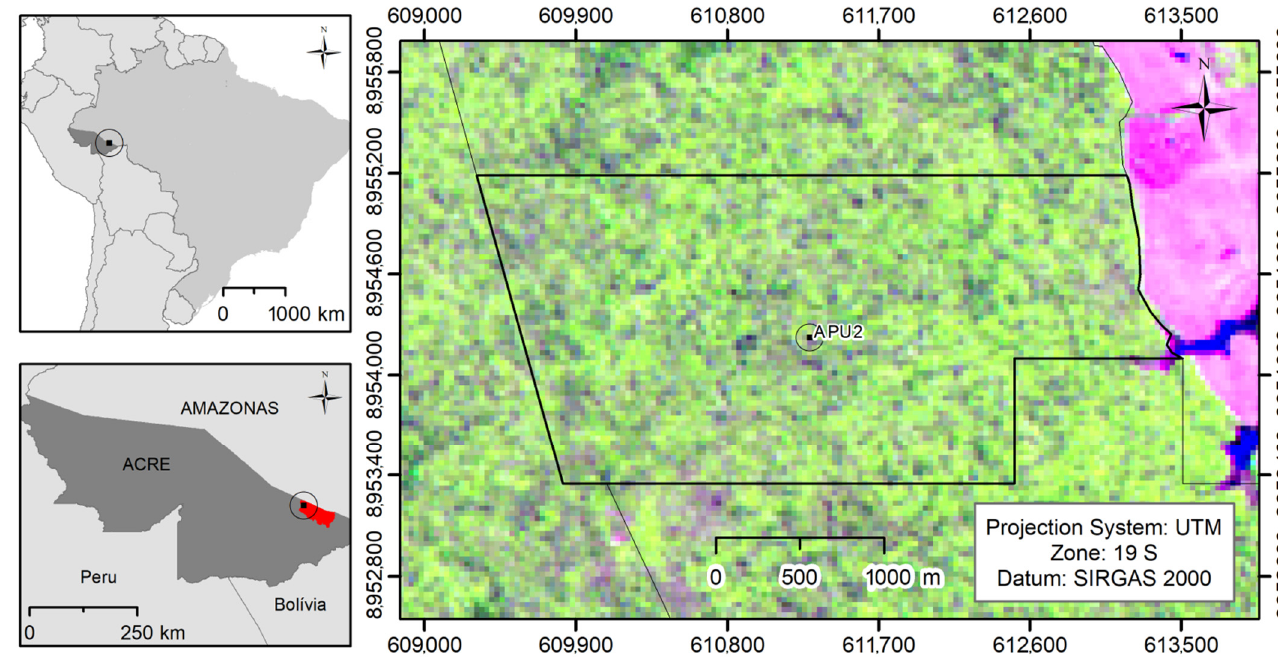
Figure 1. Location of the study area in Fazenda Antimary I and II in the municipality of Porto Acre, Acre state, Brazil, in a 1253-ha annual production unit (OLI/Landsat 8, composition 654 in RGB).